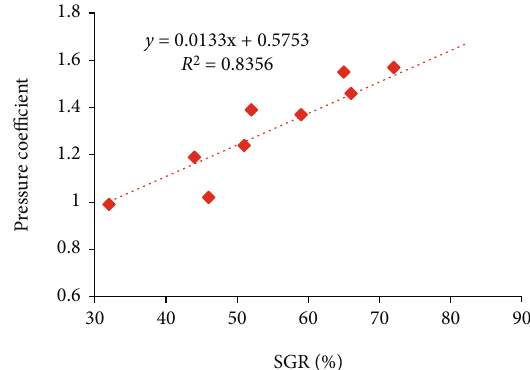
Figure 7: The relationship between SGR index and pressure coe ffi cient.